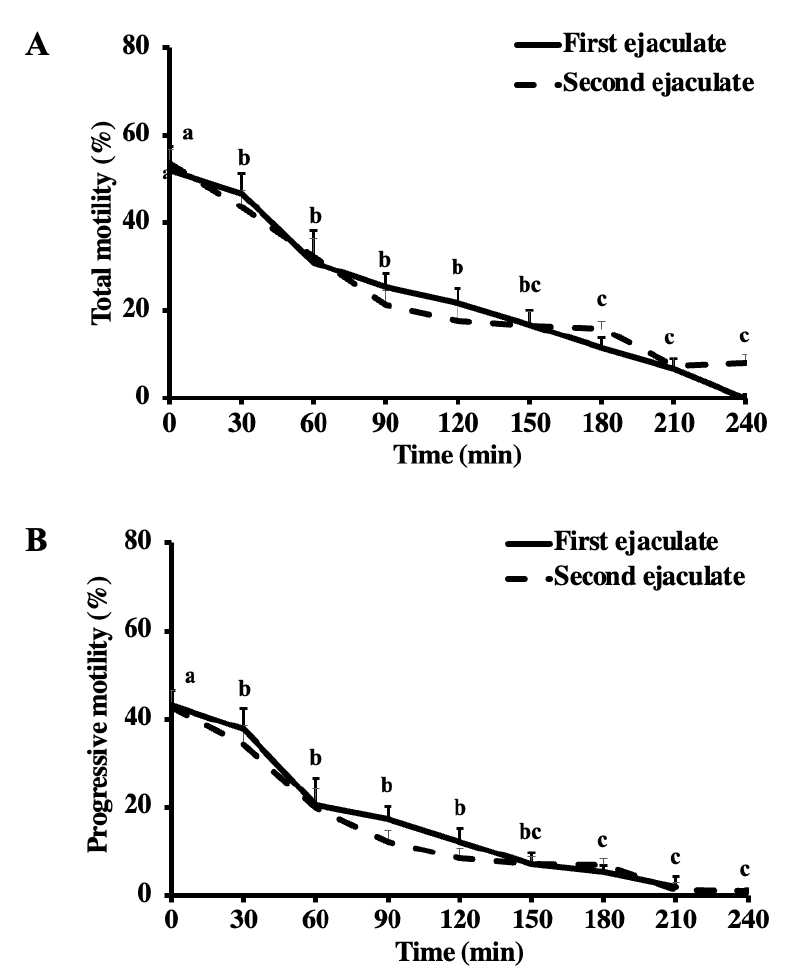
Figure 2. Total ( A ) and progressive ( B ) motility of the first and second ejaculates from breeding inactive stallions (n = 20) during the thermal longevity test. The frozen-thawed semen was incubated at 37 ◦ C for 240 min. Different superscripts ( abc ) denote a difference between columns ( p < 0.05). When the stallions were compiled into three groups, the total and progressive motilities were influenced by the freezing ( p < 0.001) and the groups ( p < 0.001) but not by their interactions ( p > 0.05) (Table 13, Figure 4). The unchanged and decreased groups had greater motility than the increased group ( p < 0.05) (Table 13). The VAP ( p = 0.2586), VCL ( p = 0.069), and VSL ( p = 0.25) were not influenced by the groups, although they were influenced by the freezing ( p < 0.001) (Table 13). During the thermal longevity test, the total and progressive motility, VAP, VCL, and VSL were not influenced by the groups, ejaculate, or the interaction between them ( p > 0.05), although they were influenced by the time (Figure 4). Both the total and progressive motility, VAP, VCL, and VSL decreased over time in every group ( p < 0.05) (Figure 4 and Table